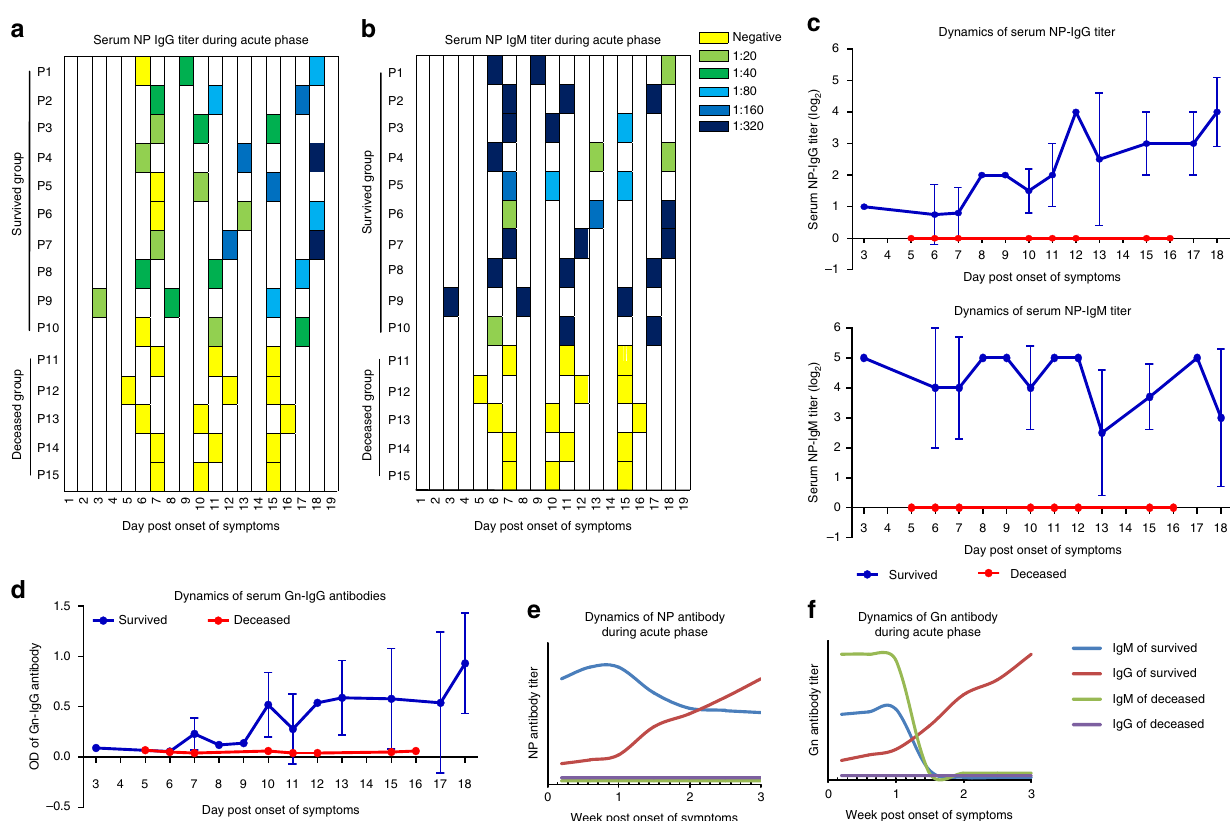
Fig. 1 Serological response to nucleocapsid protein (NP) and glycoprotein (Gn) during acute SFTSV infection. a , b Kinetics of serum IgG ( a ) and IgM ( b ) titers to NP as determined by a commercial ELISA kit in 10 survived and 5 deceased patients from 3 to 18 day post symptom onset. c Clustered data on the dynamics of IgG and IgM titers to NP in 10 survived and 5 deceased patients from 3 to 18 day post symptom onset (means ± SD). d Dynamics of IgG titers to Gn in 10 survived and 5 deceased patients from 3 to 18 day post symptom onset (means ± SD). e , f Serum antibody titers to NP ( e ) and Gn ( f ) in SFTS patients vs. time (in week) during the acute phase, based on the average titer of NP-antibody or the positive rate of Gn-speci fi c immunoreactive bands at different days. Error bar represents the standard